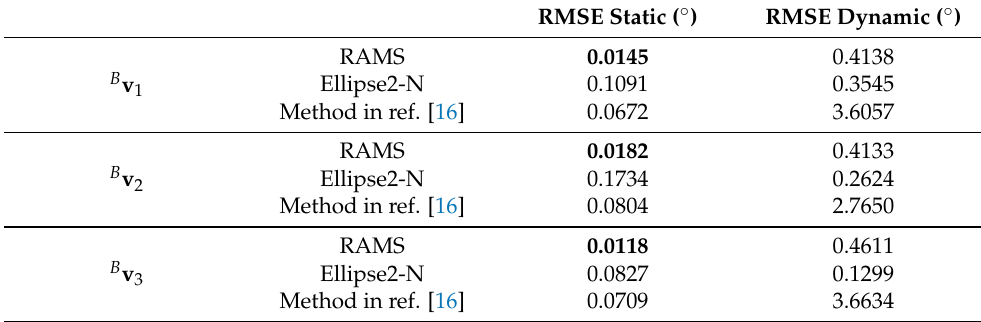
Table 5. Static and dynamic RMSE of Ellipse2-N and